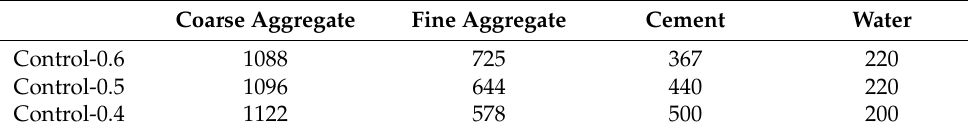
Table 5. Mix proportions of the control concrete in the laboratory tests (kg/m 3 ). Coarse Aggregate Fine Aggregate